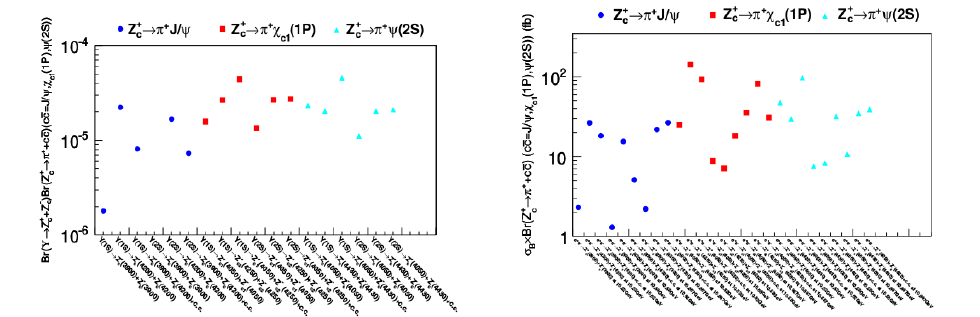
→ π + + c ¯ c ) Z (cid:48) − ) × B ( Z + √ c c c s = 10.52, 10.58, and c 1 , ψ (2 S ) at